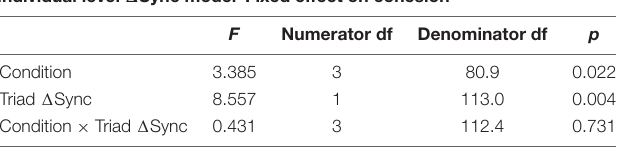
TABLE 7 | A mixed model predicting cohesion from (cid:49) Sync, task condition and their interaction at an individual level. Individual level (cid:49) Sync model–Fixed effect on cohesion